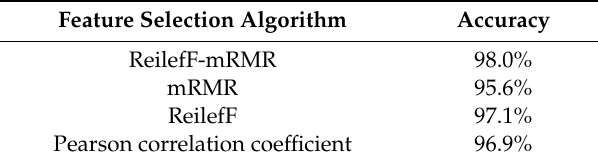
Table 5. Identification accuracy of di ff erent feature selection methods.